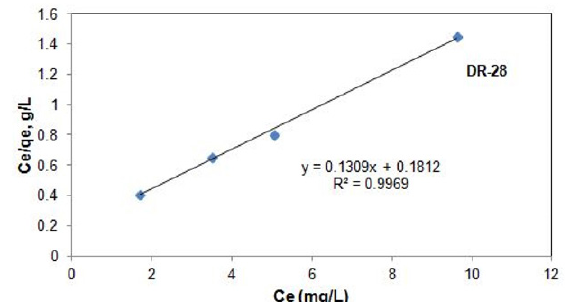
Fig. 10. Langmuir isotherm for DR-28 onto KZF (pH: original, tem- perature: 21 °C, adsorbent: KZF, adsorbent amount: 1 g/200mL)